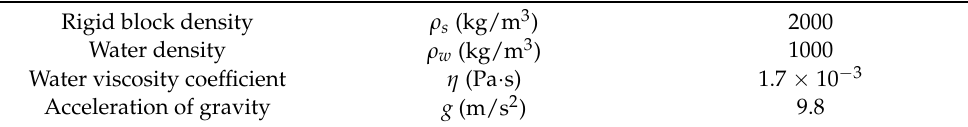
Figure 4. Experimental setup of an underwater rigid block sliding along an inclined plane. Table 1. Parameters used in the SPH simulation of the rigid block sliding experiment.